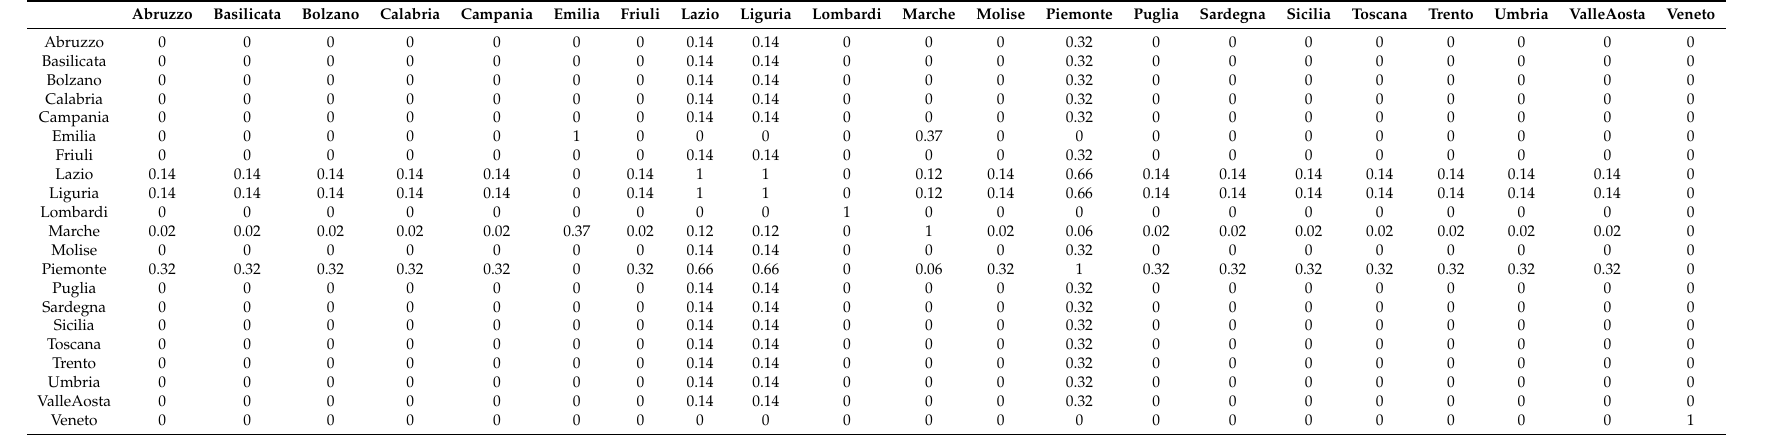
Table A8. Similarity values of Intensive Care network in the first